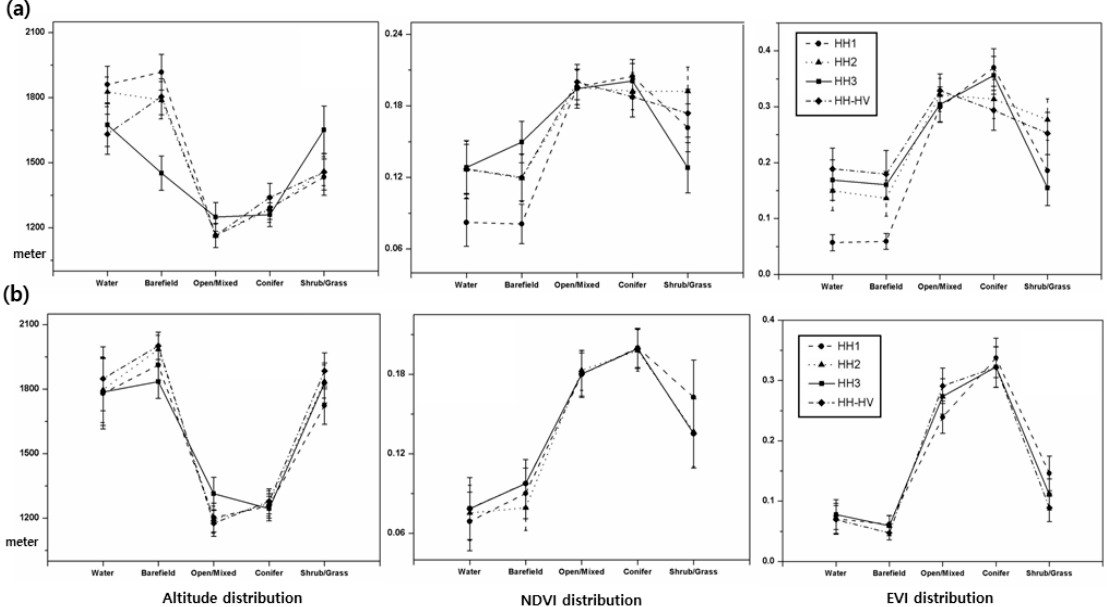
Figure 7. MODIS vegetation indexes and altitudes within classified land cover types by centered PCA ( a ) and k-PCA ( b ) schemes over Mt. Baekdu with altitude, NDVI and EVI.